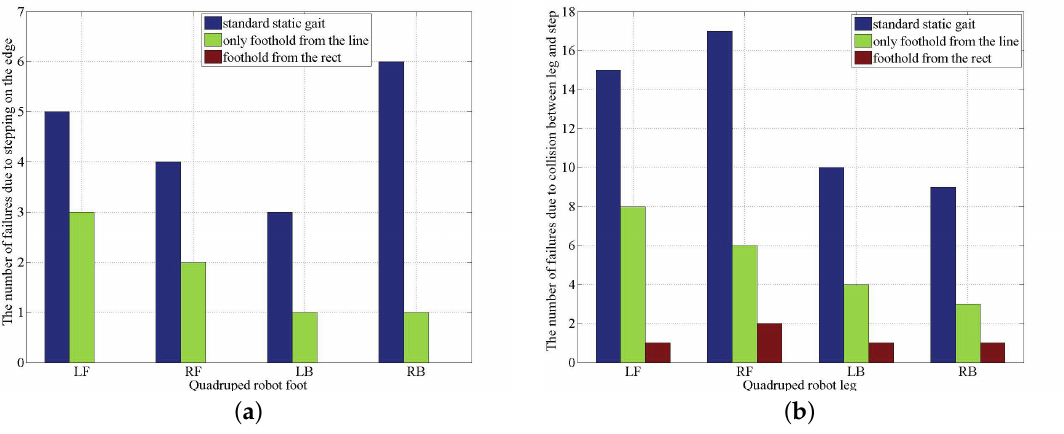
Figure 16. Comparison of the performance w.r.t. walking failure between the algorithm using standard static gait and that using a learned foothold selection. ( a ) The case of stepping on the edge of the wooden step. ( b ) The case of collision between the leg and the